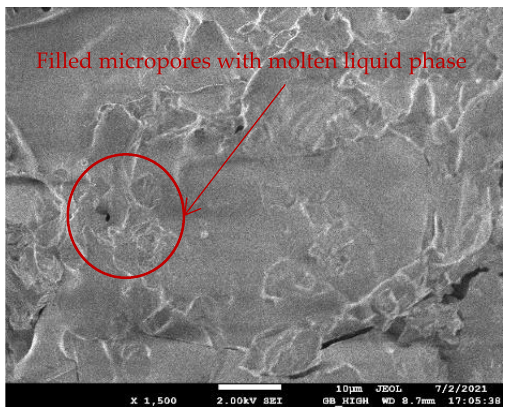
Figure 25. SEM microscopic morphology of MGS sintered bricks prepared by microwave process.